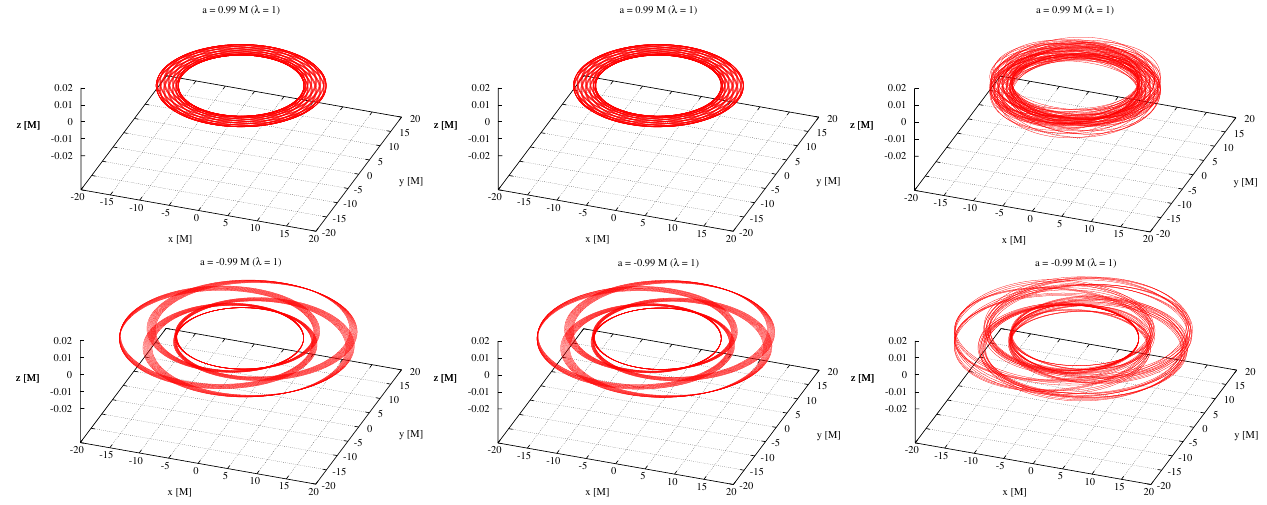
Figure 2. Orbits of MSPs around a Kerr BH with a spin a / M = + 0.99 (prograde orbit with respect to the BH spin, upper panels ) and 0.99 (retrograde orbit with respect to BH spin, lower panels ). − The black hole masses are 2 10 6 M , 10 5 M and 10 3 M ( left to right ). The mass of the MSP is × (cid:12) (cid:12) (cid:12) m = 1.5M . The spin period of the MSP is 1ms, and the spinning axis is tilted at an angle of π /4 (cid:12) toward the BH initially. Adopted from Singh, Wu and Sarty [37].